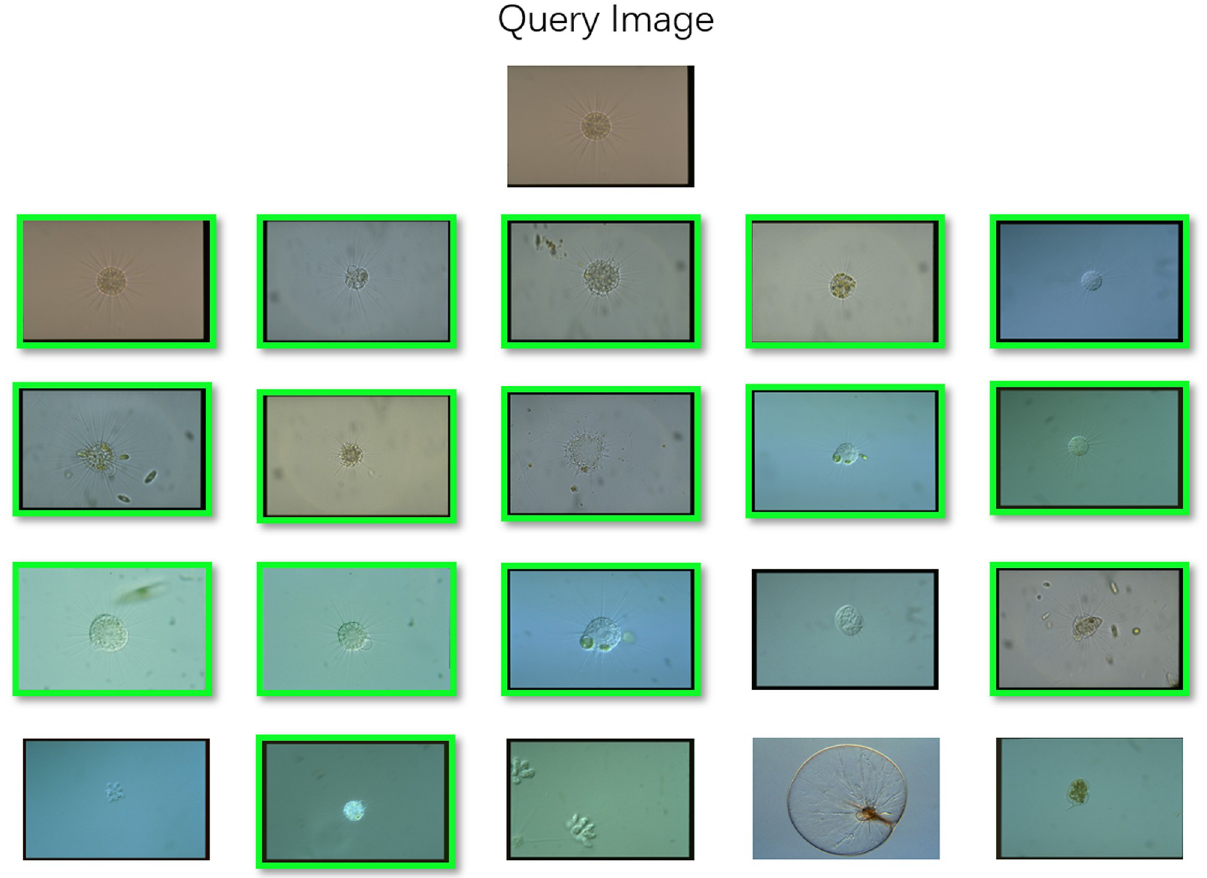
Fig 11. An example of image retrieval results based on VGG16 feature using EMDS-5.